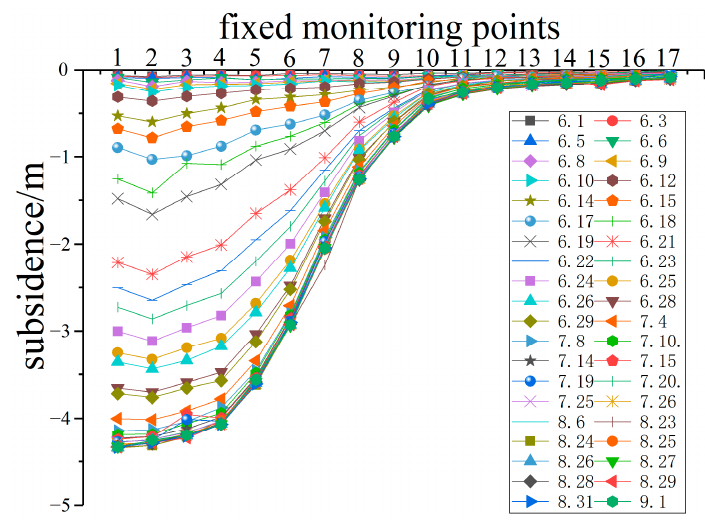
Figure 2. Subsidence data obtained from fixed monitoring points (perpendicular to the mining direction). The legend is the date of the measurement. Source: Built on the basis of the author’s field survey and calculations.